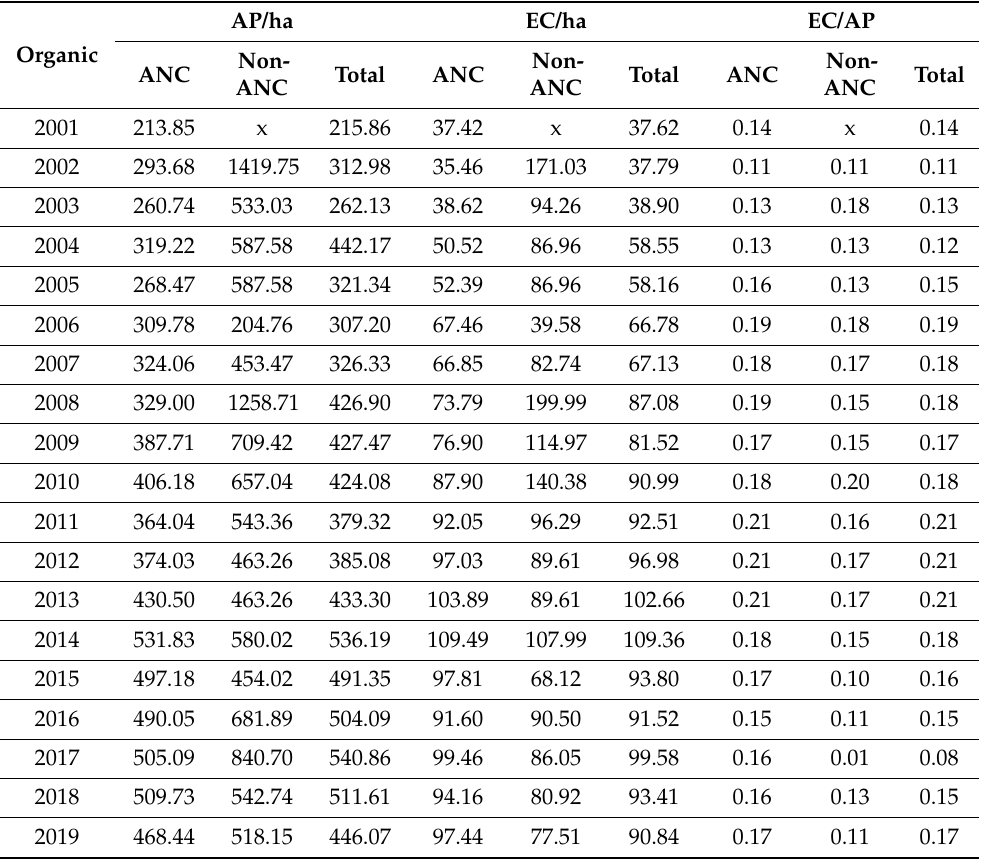
Table A2. Performance (AP) and direct energy consumption (EC) in conventional farming.